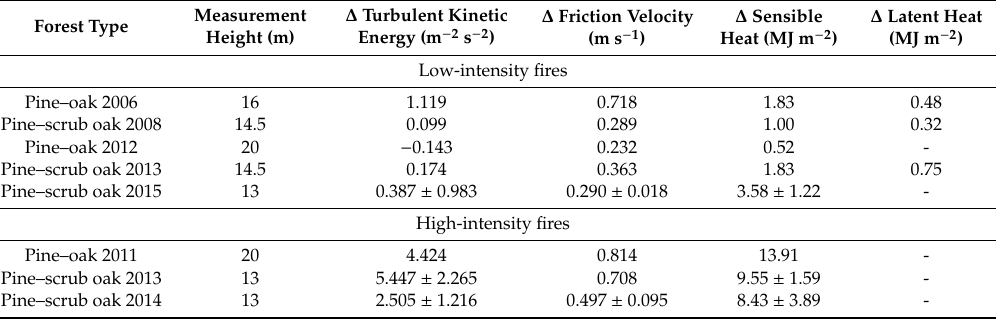
Table 6. Measurement height above the ground and maximum differences between burn area and control towers ( ∆ values) for turbulent kinetic energy calculated at 1 min intervals, and friction velocity, sensible heat fluxes and latent heat fluxes calculated at 10 min intervals for the eight prescribed